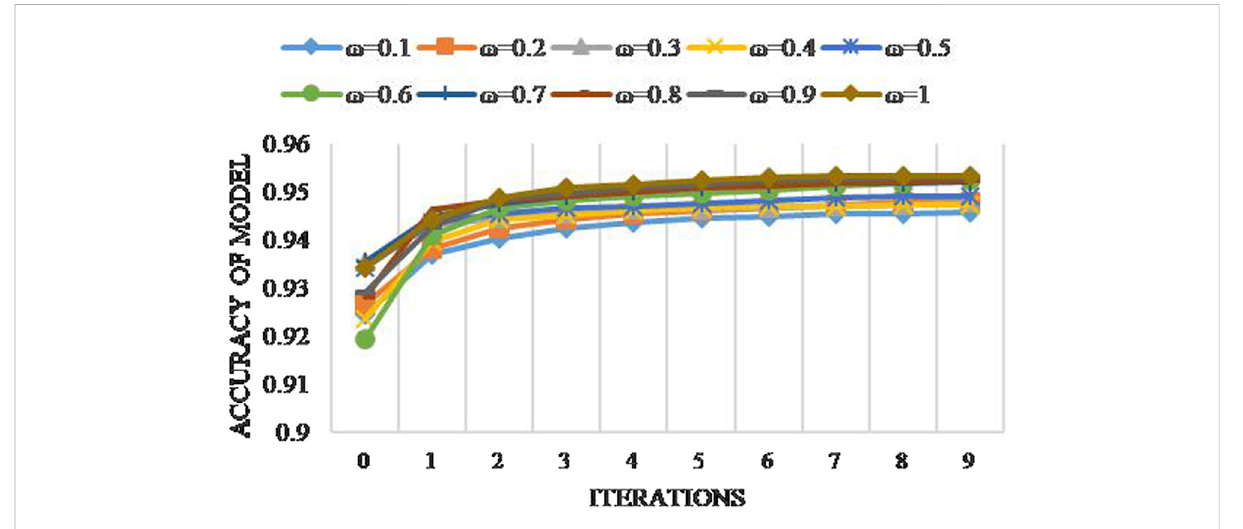
FIGURE 9 Iteration curves of the PSO-DBN model with different inertia